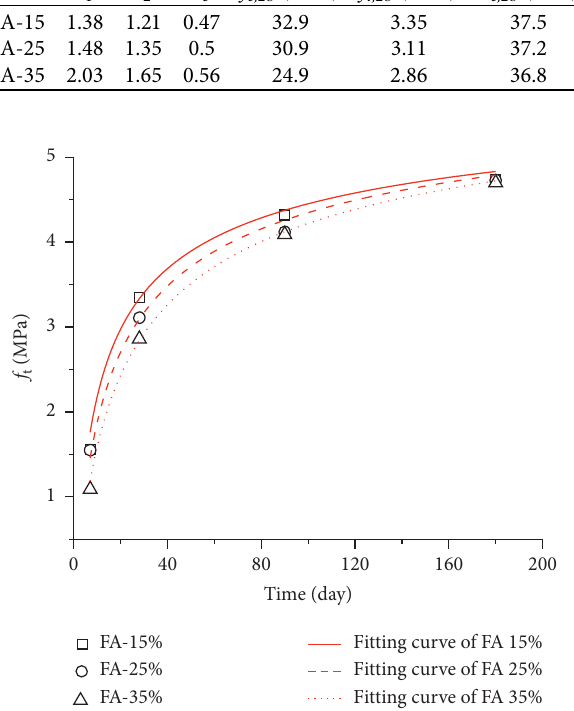
Figure 6: The tensile strength development at varying ages.